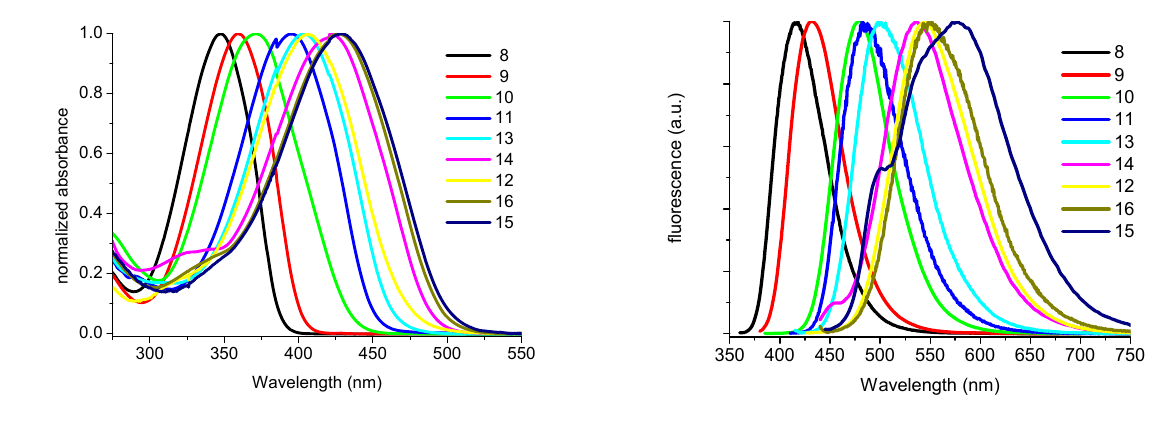
Figure 9. Normalized absorption (left) and normalized fluorescence emission (right) spectra of compounds 8 – 16 in CH